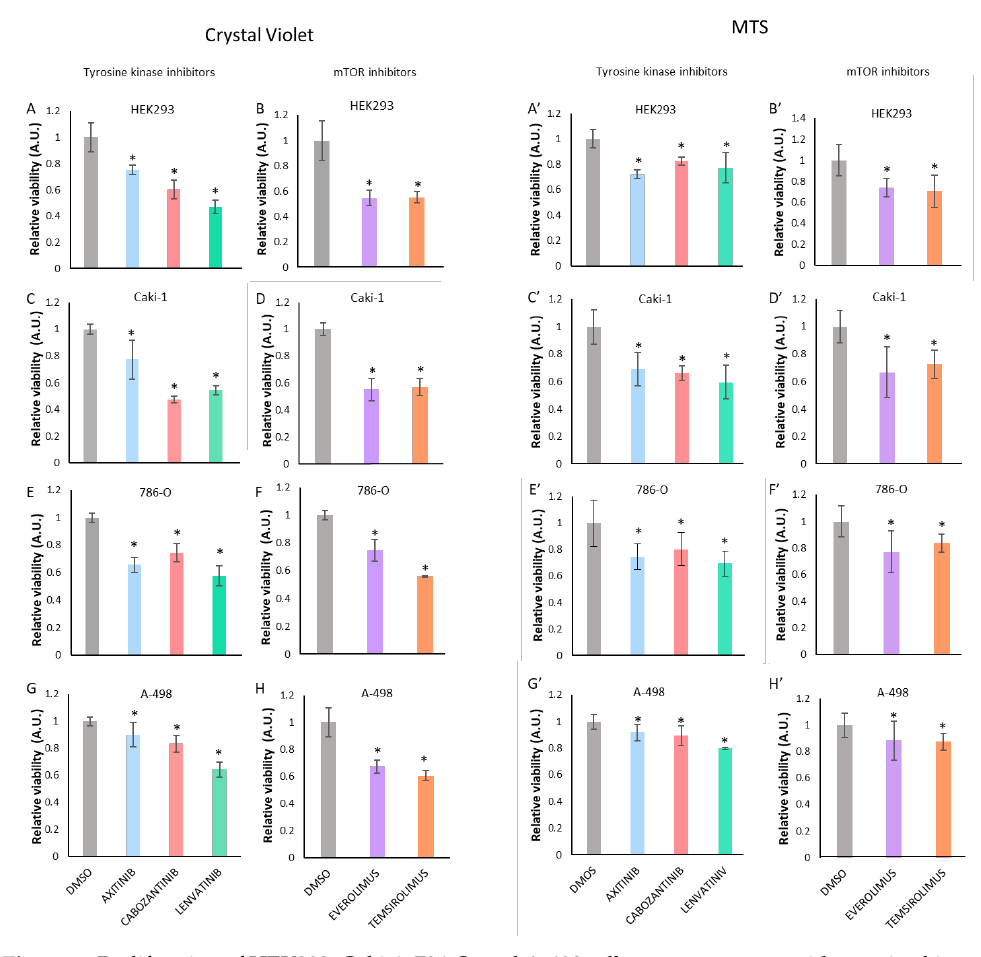
Figure 1. Proliferation of HEK293, Caki-1, 786-O, and A-498 cells upon treatment with tyrosine kinase inhibitors or with mTOR inhibitors. Crystal violet (CV) staining ( A – H ) and MTS assays ( A ’– H ’) were used to measure viability of cells upon treatment with tyrosine kinase and mTOR inhibitors after 72 h. Concentrations used were 1 µ M Axitinib, 1 µ M Cabozantinib, and 1 µ M Lenvatinib in HEK293 cells ( A , A ’); and 20 µ M Axitinib, 8 µ M Cabozantinib, and 20 µ M Lenvatinib in Caki-1 ( C , C ’), 786-O ( E , E ’), and A-498 ( G , G ’) cells. Everolimus and Temsirolimus were used at 0.1 µ M in all cells ( B , B ’, D , D ’, F , F ’, H , H ’). Note that HEK293 cells were more sensitive to the TKI treatments than the other renal cancer cells. Data are shown as relative proliferation ± S.D. Statistically significant results ( p < 0.05) are marked with *. All data were normalized relative to untreated cells and are shown in arbitrary units